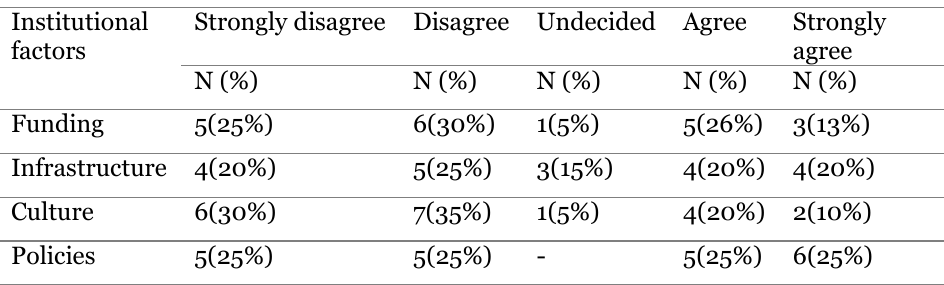
Institutional Factors That Determine E-Learning